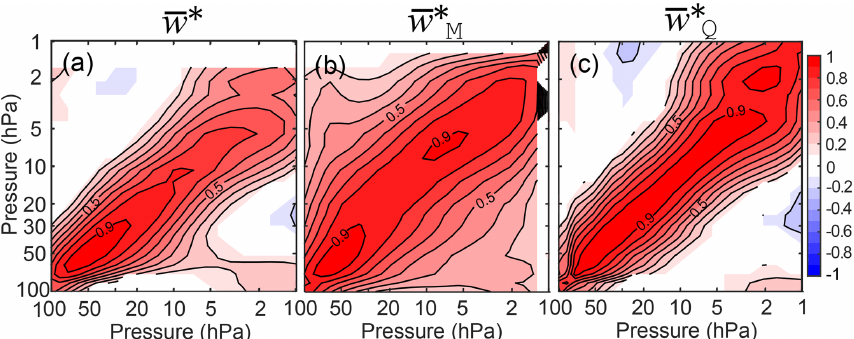
Figure 4. Cross-correlation of the variability in the calculations of the residual circulation with the turnaround latitudes ( y axis) and the fixed tropics, 30 ◦ S and 30 ◦ N, ( x axis). (a) Direct calculation, (b) momentum calculation, and (c) thermodynamic calculation. Contour lines are every